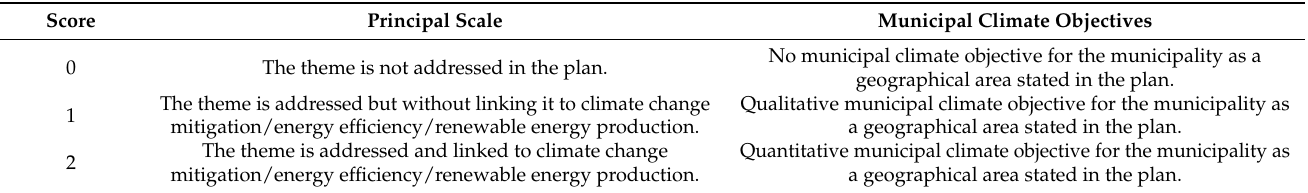
Table 2. The specifications of the scale for scoring plans. The principal scale applies to all identified themes except the theme Municipal climate objectives, which have its scale specified in the